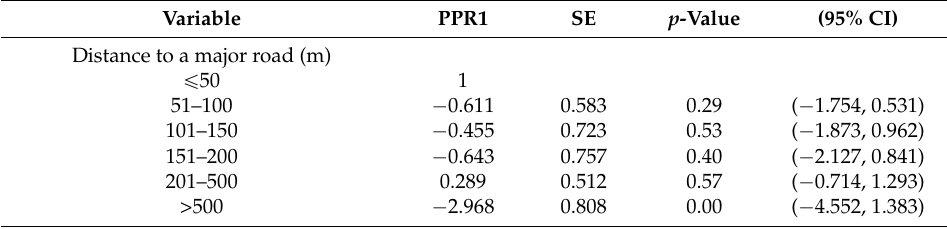
Table A8. Distance to major roads proportions of sleep disturbance due to road traffic in the weighted study sample, adjusted for sensitivity to noise: regression